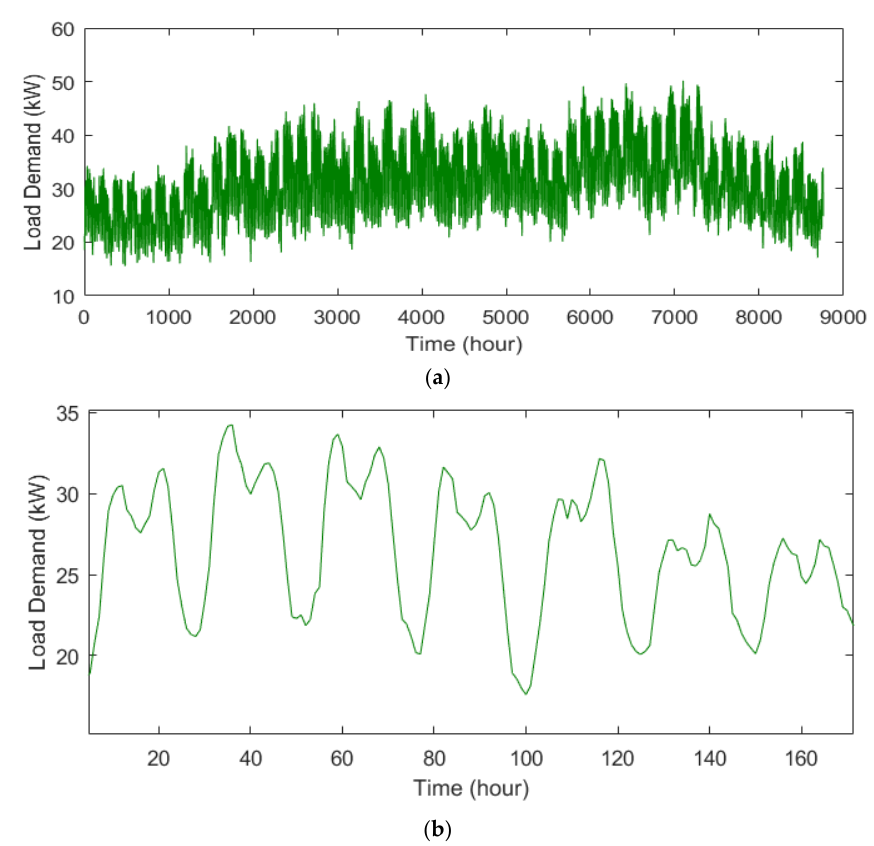
Figure 5. Annual load demand curve of the residential complex during ( a ) a year and ( b ) a week. Table 1 reports the technical and economic specifications of the HES equipment. Table 1. Techno-economic data of the PV/FC energy system [15,36].